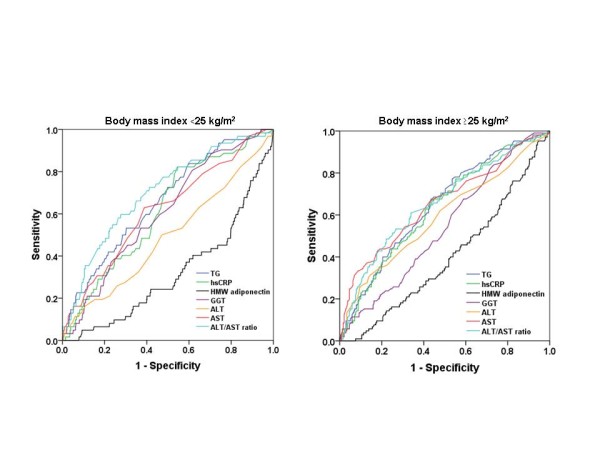
Receiver operating characteristics (ROC)curves. Sensitivity represents the true-positive results and 1-specificity, the false-positive results. The best markers have ROC curves that are shifted to the left with areas under the curve near unity. Nondiagnostic markers are represented by diagonals with areas under the ROC curves close to 0.5.